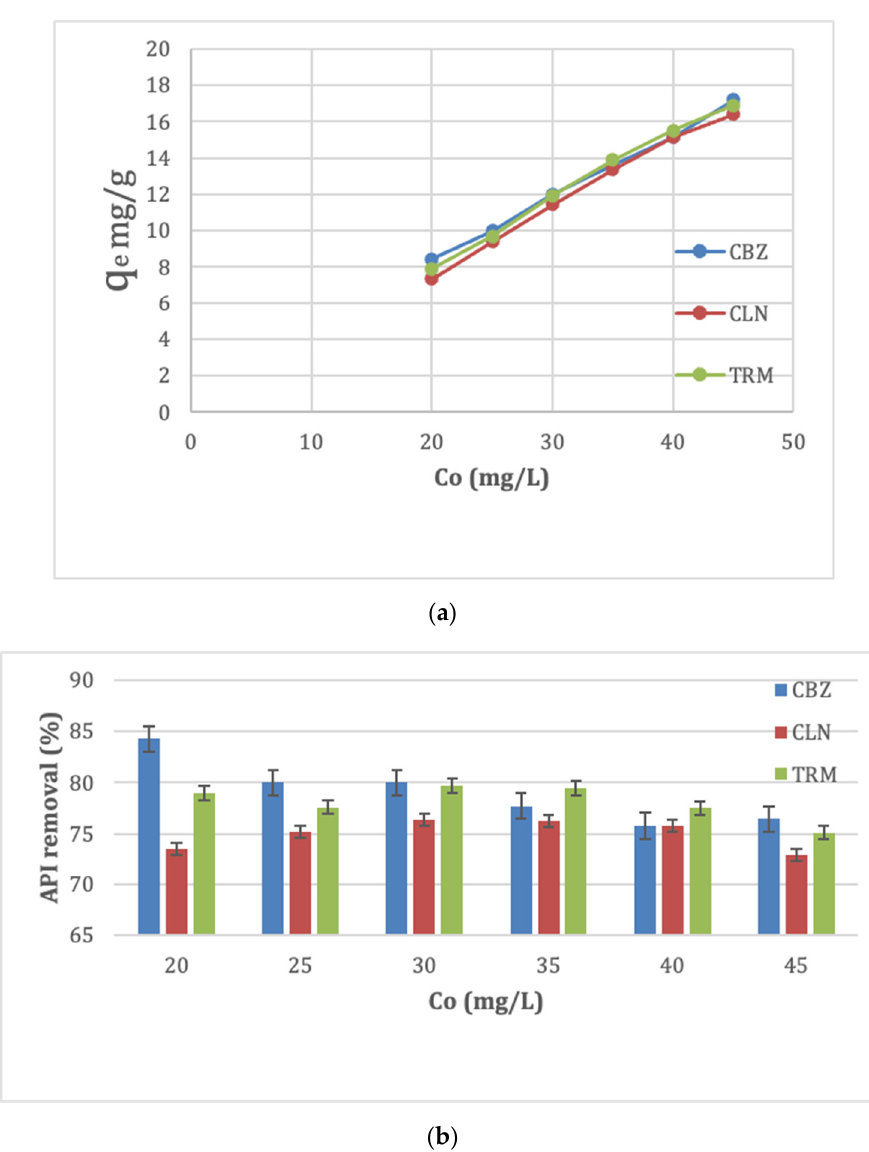
Figure 5. Effects of the initial APIs concentration on ( a ) the equilibrium adsorption capacity and ( b ) the API removal.